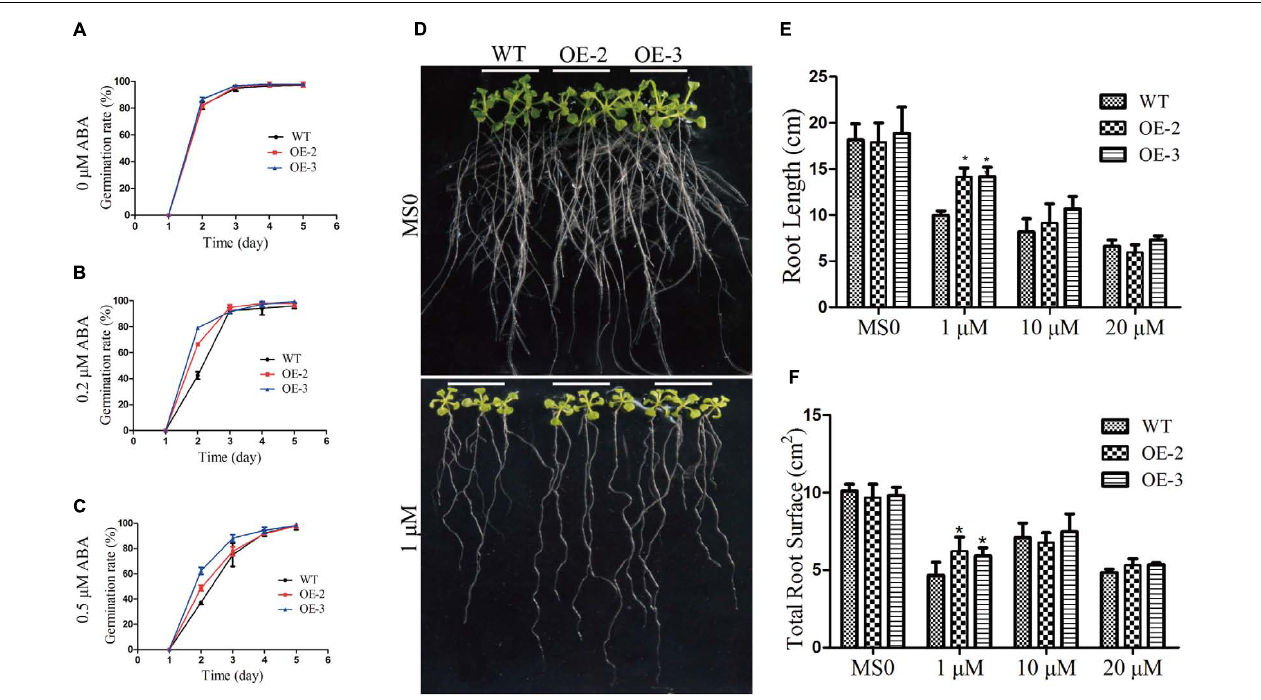
FIGURE 8 | Responses of wild type and transgenic plants to ABA treatment. Seed germination assay. (A) Statistical analysis of seed germination on 1/2 MS medium (about 100 seeds for each line). (B) Statistical analysis of seed germination on 1/2 MS medium with 0.2 µ M ABA. (C) Statistical analysis of seed germination on 1/2 MS medium with 0.5 µ M ABA. (D) Phenotypes of WT and transgenic seedlings under ABA treatment. Four-day-old seedlings of two transgenic lines and WT Arabidopsis were planted on 1/2 MS medium with or without ABA for 10 days. (E) Comparative root lengths of WT and transgenic lines. (F) Total root surface of WT and transgenic lines ( n = 27). The data are shown as mean ± SD ( n = 27). Independent t -tests demonstrated that there was significant difference ( ∗ P <